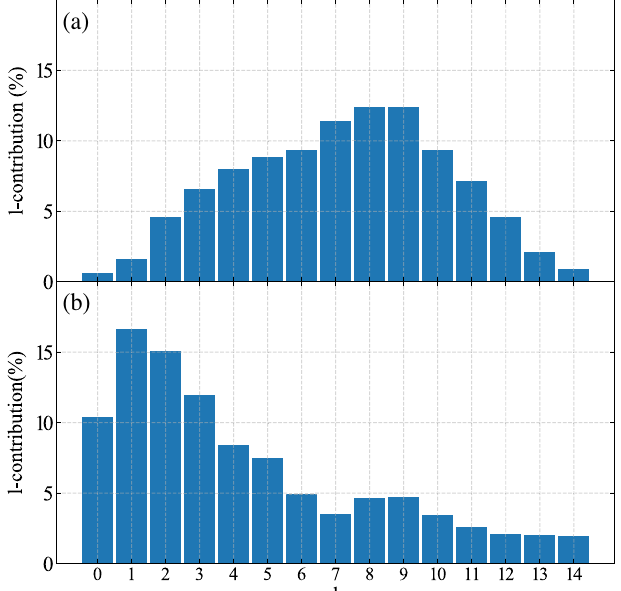
FIG. 11. Convergence of TDSE calculations with respect to the highest angular momentum l introduced in the computations: C l contributions to the ionizing density when the Yukawa-screened toy molecule is subject to a bicircular corotating field with intensity I ω ¼ 2 × 10 13 W : cm − 2 and r ¼ 0 . 1 (a) and to an OTC field with I ω ¼ 5 × 10 13 W : cm − 2 and r ¼ 0 . 1